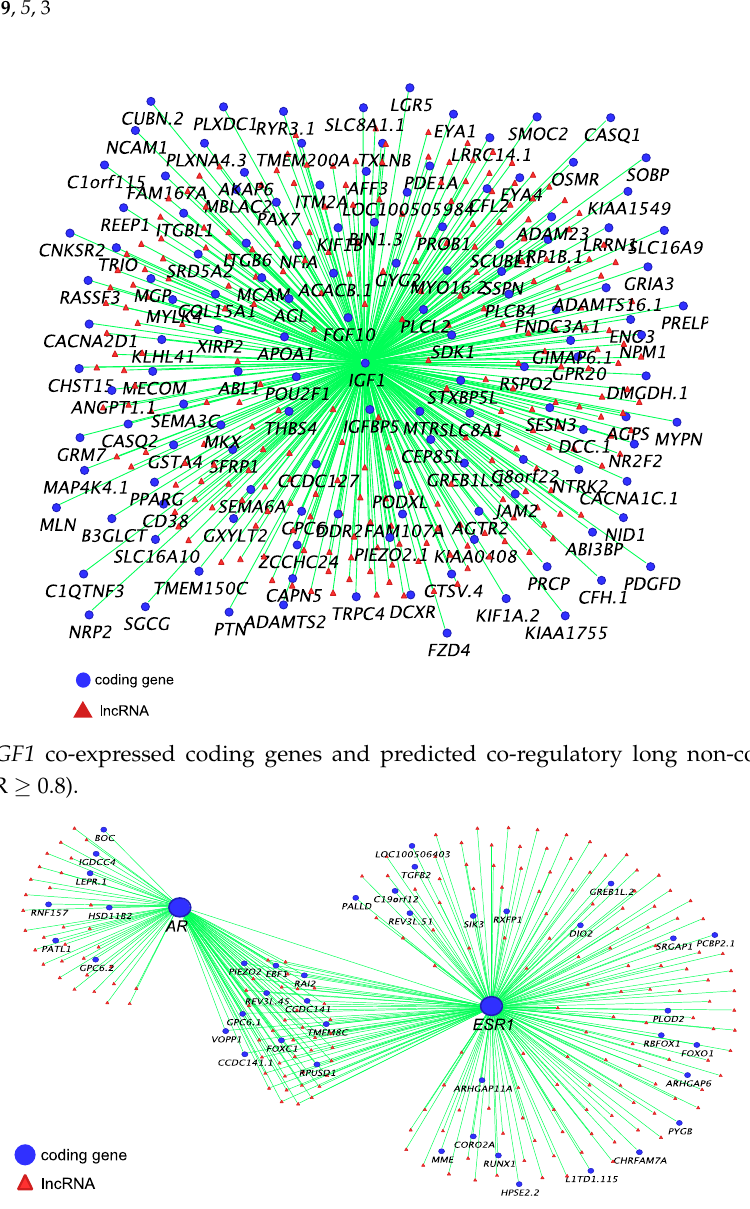
Figure 3. AR and ESR1 co-expressed coding genes and predicted co-regulatory lncRNAs (R ≥ 0.7).